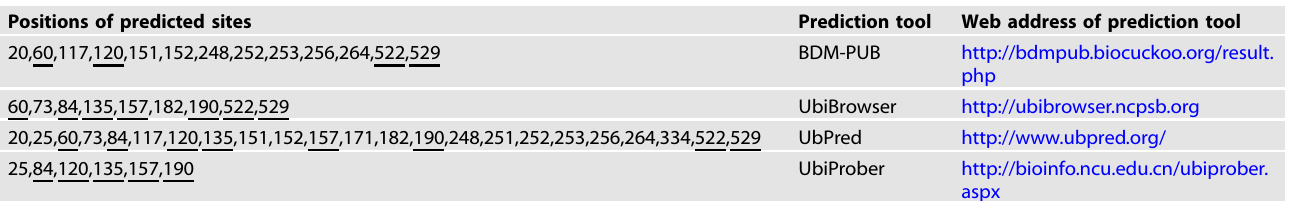
Table 1. Prediction of CPNE1 ubiquitination